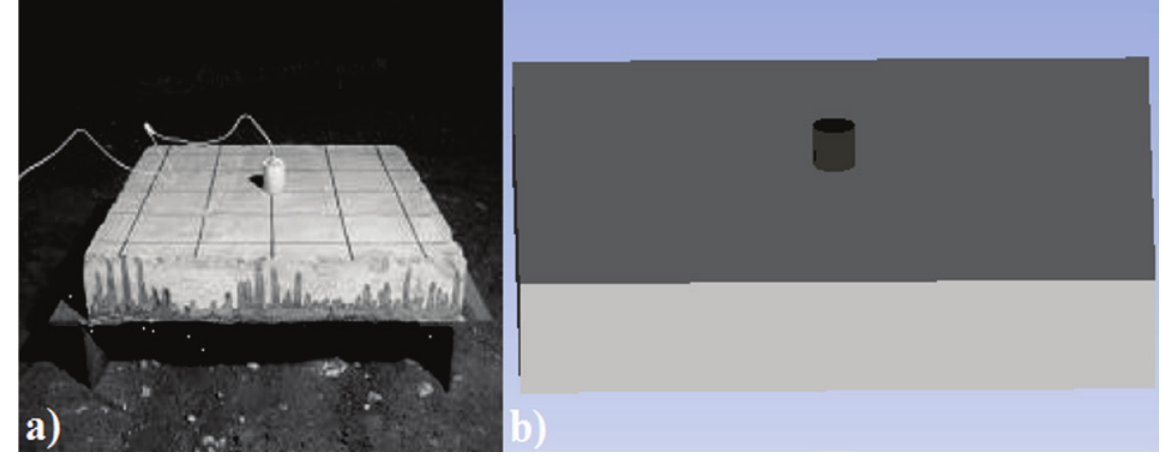
a) experimento desenvolvido por Beppu et al. [15], b) modelo numérico desenvolvido no Autodyn